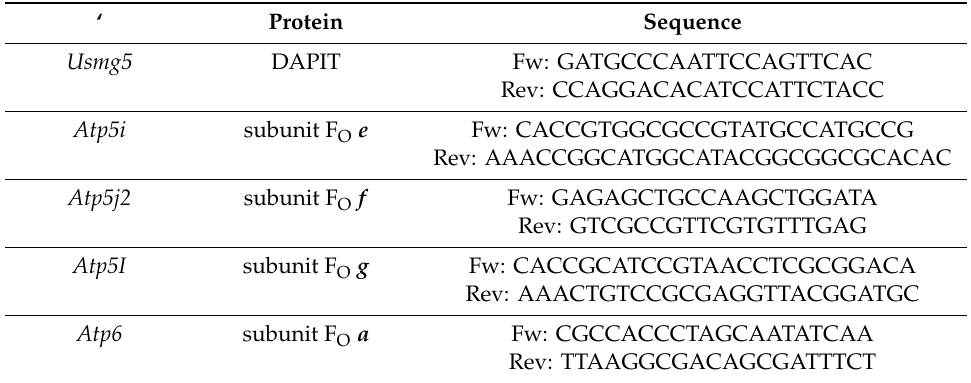
Table 1. Primers used to identify individual